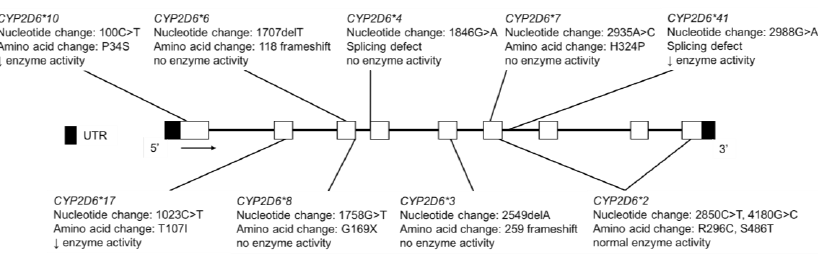
Figure 9. The human CYP2D6 gene and variants tested for in the Inuit, FN, CSKT, AI youth and Amerindian populations. For variants that are part of a haplotype group, only the diagnostic SNVs commonly tested are shown. Not shown are copy number variations, CYP2D6*5 , a full gene deletion and CYP2D6*35 , which has normal enzyme activity and is the result of multiple nucleotide changes (−1584C > G, 31G > A, 1661G > C; 2850C > T and 4180G > C) and amino acid changes (V11M, R296C and S486T) in multiple exons. Open boxes represent exons, lines represent introns and shaded boxes represent UTR.